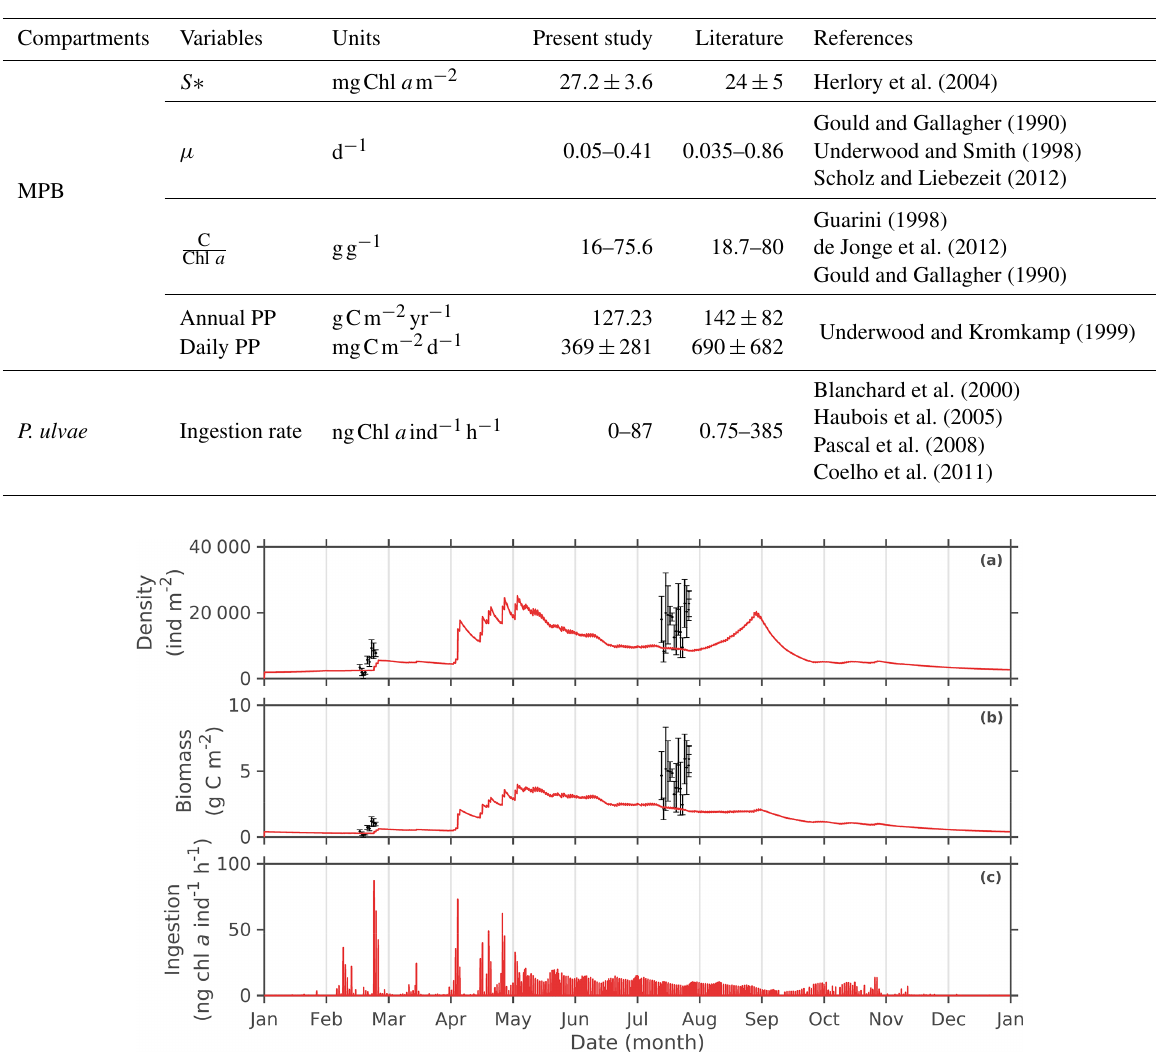
Figure 8. Seasonal cycle of the 2008 (a) simulated P. ulvae density (indm − 2 ), (b) simulated P. ulvae biomass (gCm − 2 ), and (c) simu- lated individual ingestion rate by P. ulvae (ngChl a ind − 1 h − 1 ). Black dots (mean) and error bars (standard deviation) correspond to in situ